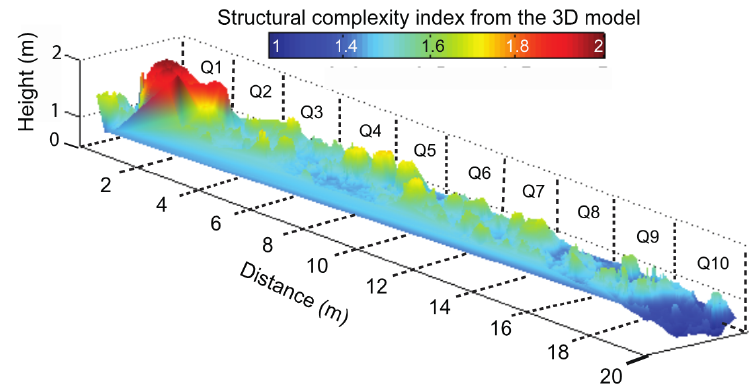
Figure 6. Heat-map of structural complexity of a section of a 400 m 2 reef area. Both x and y axes are marked in meters, each quadrat is 2 × 2 m. Structural complexity was calculated as in Equation (1), where a value of 1 represents a flat quadrat, and a higher value a more complex quadrat.